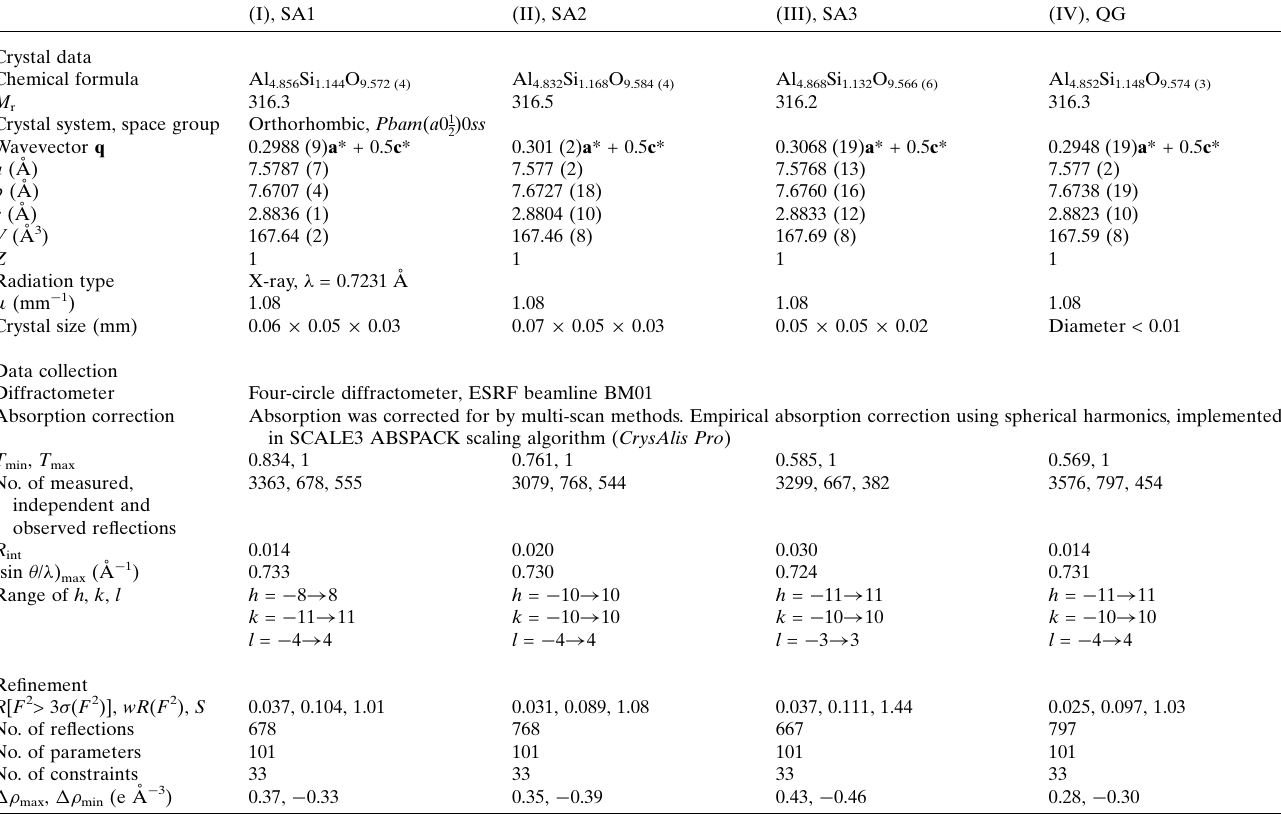
Table 1 Experimental details ( T = 293